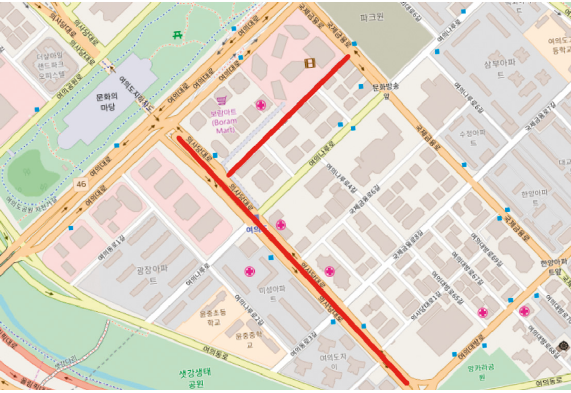
Figure 1: Seoul map from